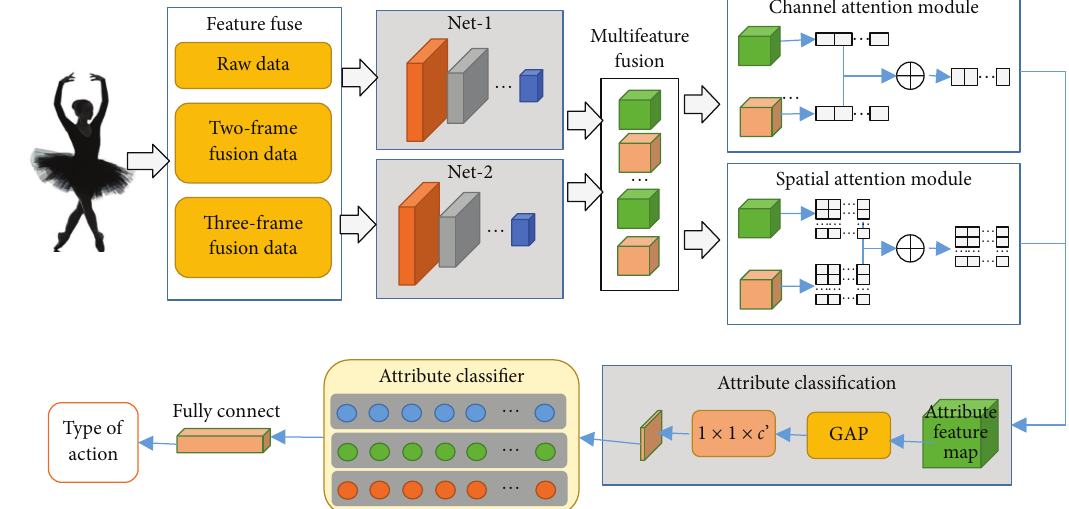
Figure 4: Structure diagram of action recognition algorithm based on feature expression and attribute